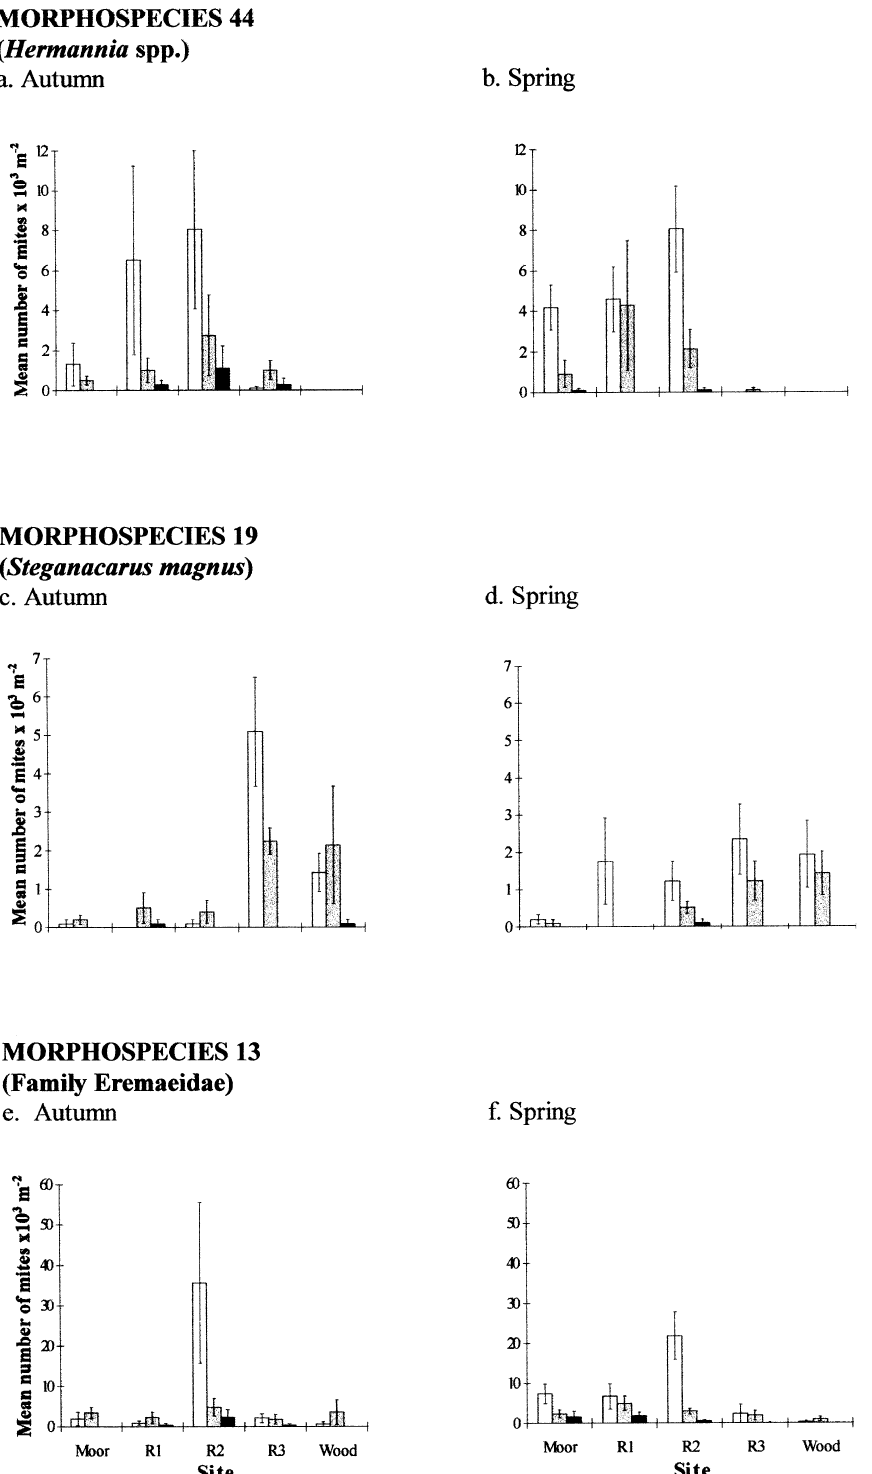
Fig. 1. The mean density of morphospecies 44 ( HermanniaI spp.) (a and b), morphospecies 19 ( Steganacuarus magnus ) (c and d) and morphospecies 13 (Family Eremaeidae) (e and f) at all Loch Garten transect sites during 1998 and 1999. ( : litter; : 0–5 cm; and : 5–10